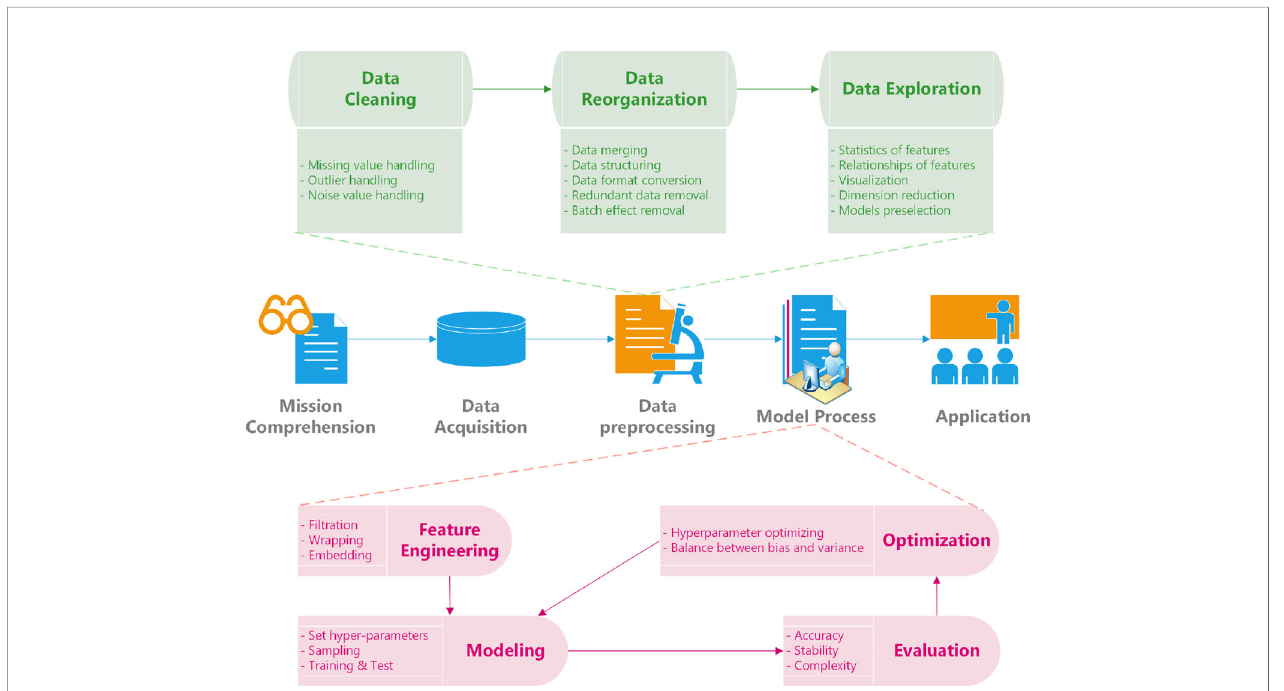
FIGURE 1 | Data mining process of ctDNA detection. ctDNA, circulating tumor